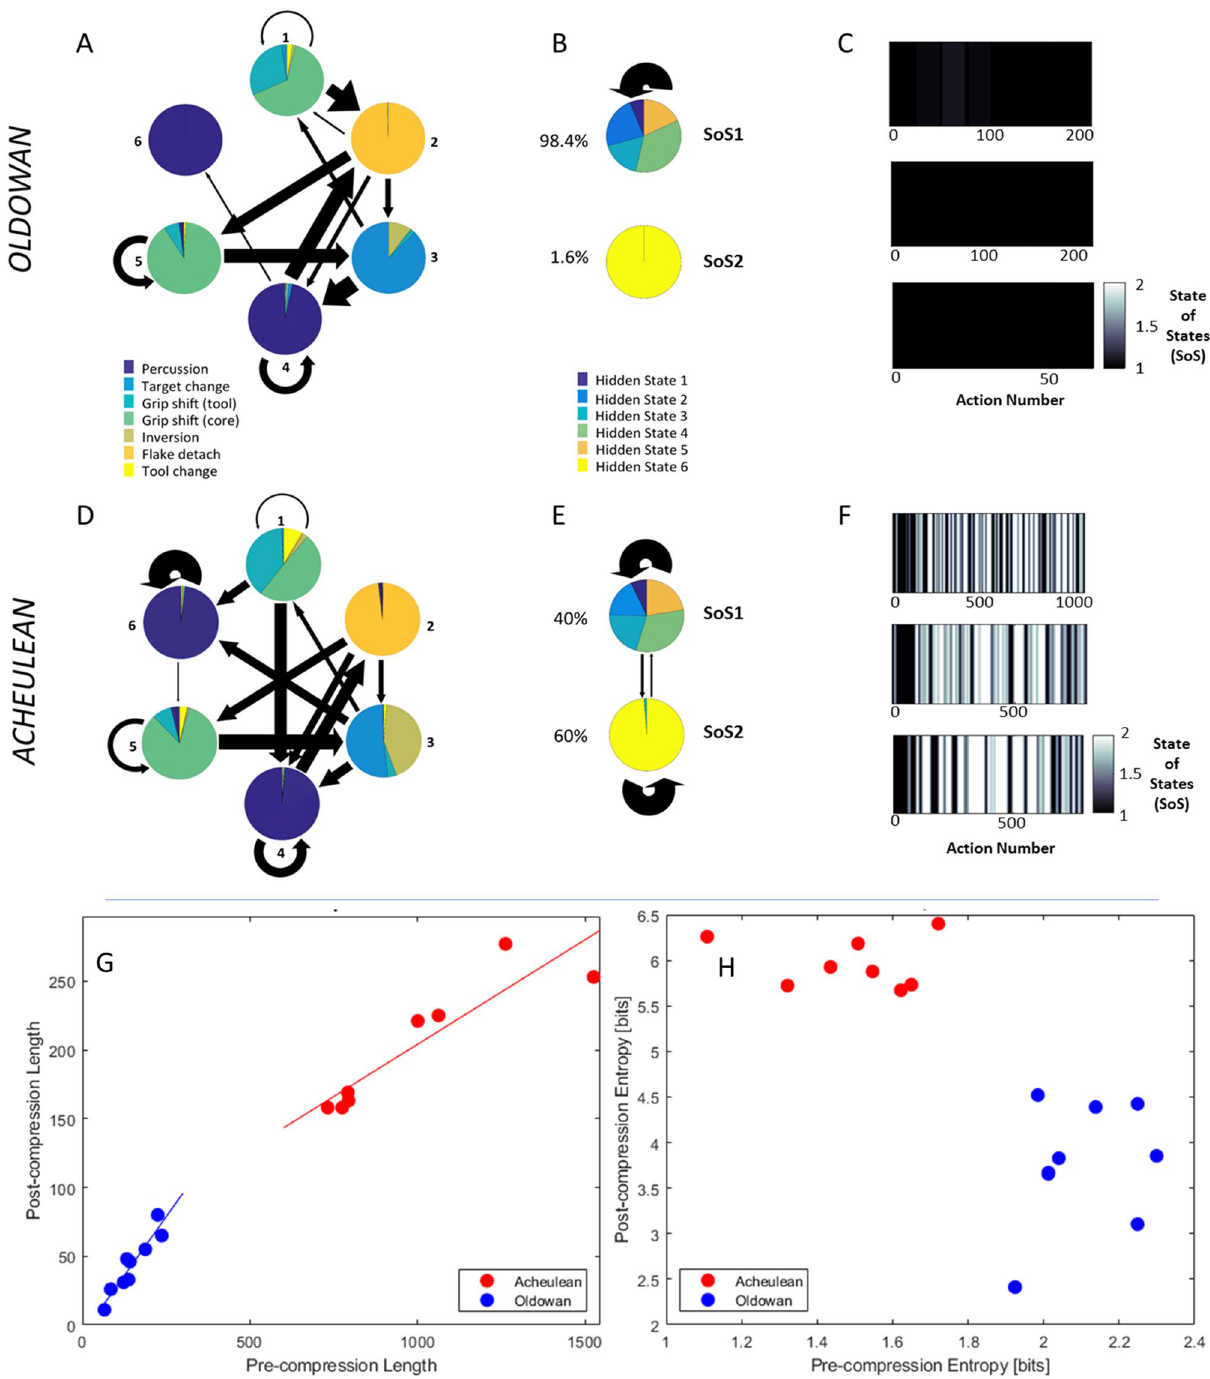
Figure 3. Results of grammatical analysis: HMM analysis ( A – F ) Empirical transition (arrows) and emission (pie charts) matrices of 6-state HMM fitted to all Oldowan (A) and Acheulean (D) sequences. Arrow thickness indicates transition probabilities between states (values < 5% not displayed). Pie chart area indicates probability of an action being performed in that state. Oldowan Hidden State 6 accounts for less than 2% of all data points. In the middle are similar illustrations of the superordinate "States-of-States” for Oldowan ( B ) and Acheulean ( E ) data. At right are examples of the running average State of States for Oldowan ( C ) and Acheulean ( D ) time-series. Black: everything in SoS 1; white: everything in SoS 2. Sequitur analysis ( G , H ): Effect of Sequitur compression on Acheulean (red) and Oldowan (blue) sequences, show clear differences between Oldowan and Acheulean sequences as measured by pre- and post-compression length ( G ). Note, how the slope of pre/post compression straight line fits is clearly different between Oldowan and Acheulean. Similarly, the information content within the uncompressed and compressed sequences as measured is clearly different ( H